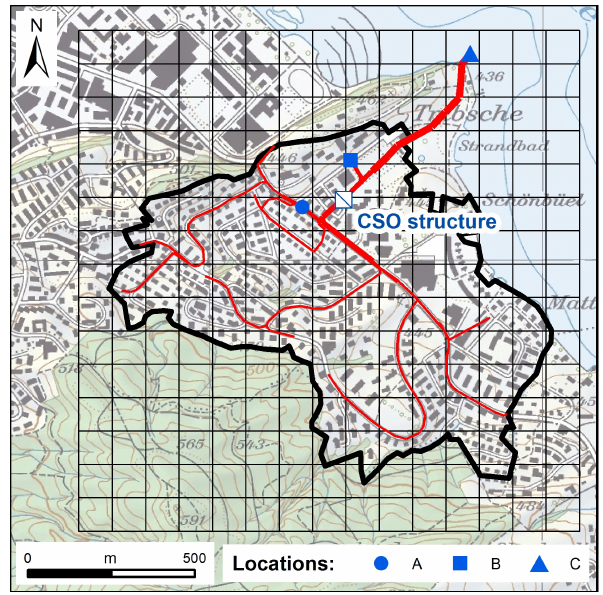
Figure 1. Location map of the case study catchment (bounded with black line). The black mesh represents the 1.5km × 1.5km domain (grid cell resolution of 100m × 100m) for which stochastic rainfall was generated. The red lines represent the drainage system (thicker lines per pipe diameter) and the blue circle (inner network node), rectangle (carry-on flow) and triangle (combined sewer overflow) symbols represent the location for which the flow analysis was con- ducted. The combined sewer overflows (CSO structure, blue romb symbol) are located between locations A and